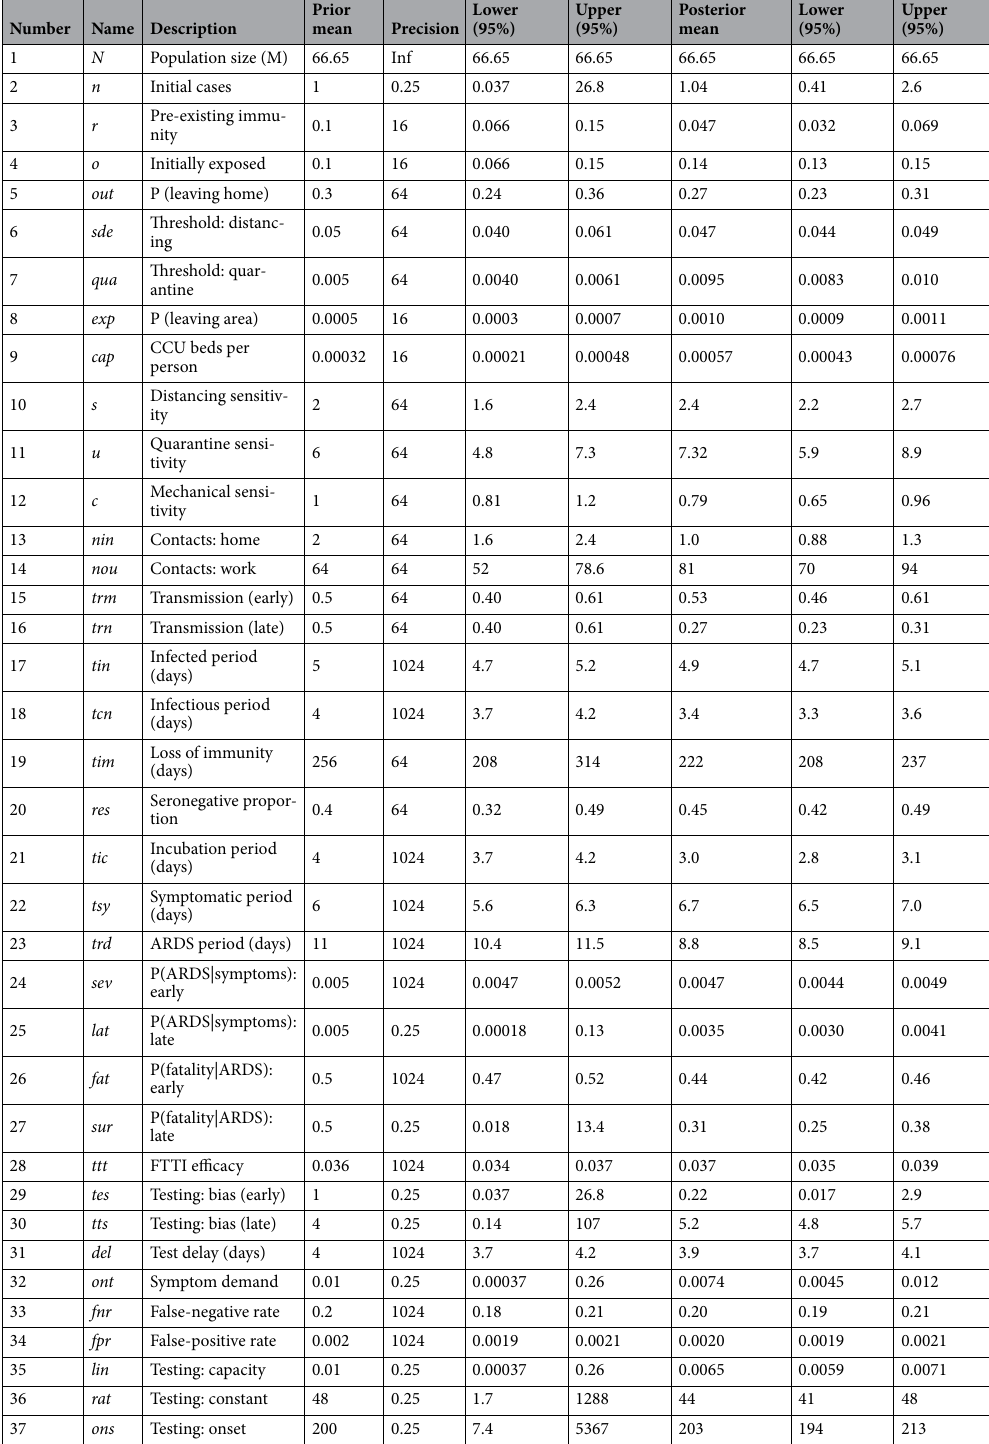
Table 1. Parameters of the dynamic causal model. Sources: Refs. 18,19 . Table 1 lists the parameters of this model, their priors and their posteriors based upon the data above. The free parameters are listed in the second column and their role in shaping the epidemiological dynamics is described in the Supplementary